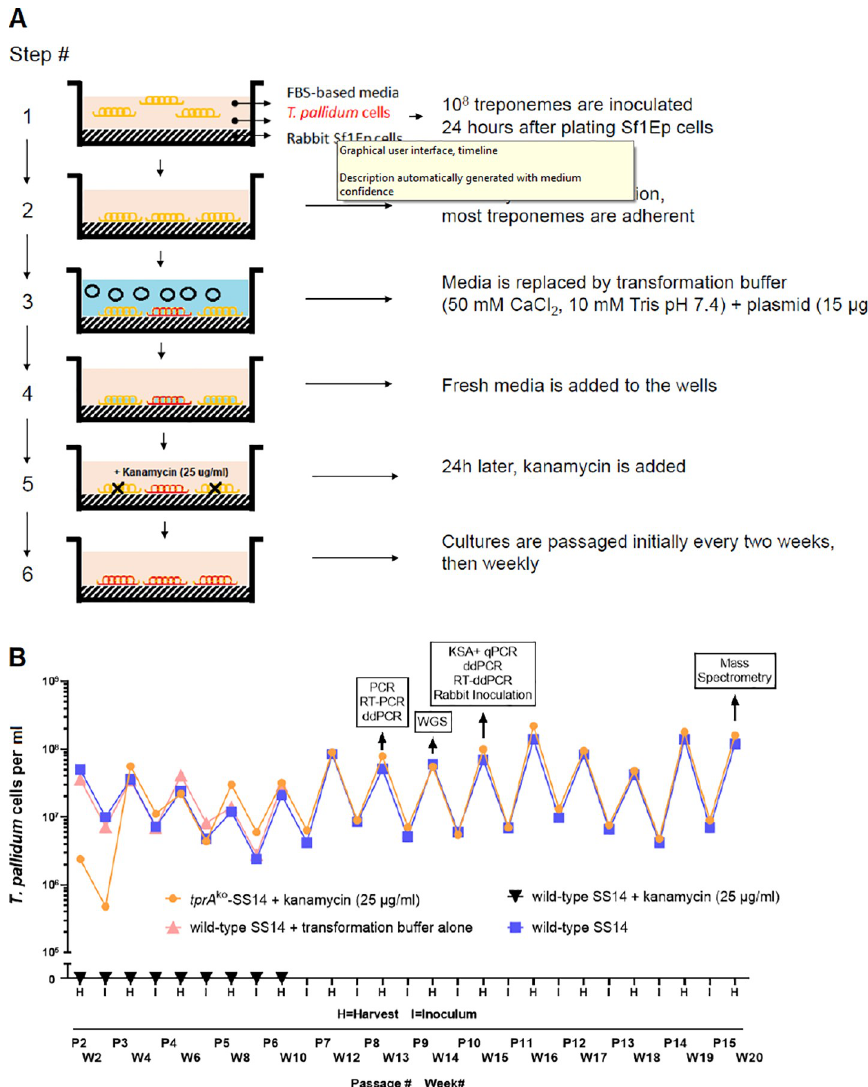
Fig 1. Transformation of T . pallidum and propagation of the transformed strain. ( A ) Schematic of the six-step procedure applied to transform T . pallidum . Treponemes labelled in red represent tprA ko strain cells. ( B ) Twenty-week in vitro growth curve of SS14 T . pallidum cells post-exposure to p tprA arms- tp0574 prom- kan R plasmid in transformation buffer (orange), transformation buffer alone (pink), media containing kanamycin (black), compared to the wild-type SS14 strain (blue). RT-PCR: reverse-transcription-PCR; ddPCR: droplet digital PCR; RT-ddPCR: reverse-transcription droplet digital PCR; WGS: whole-genome sequencing; KSA: kanamycin susceptibility assay; qPCR: quantitative